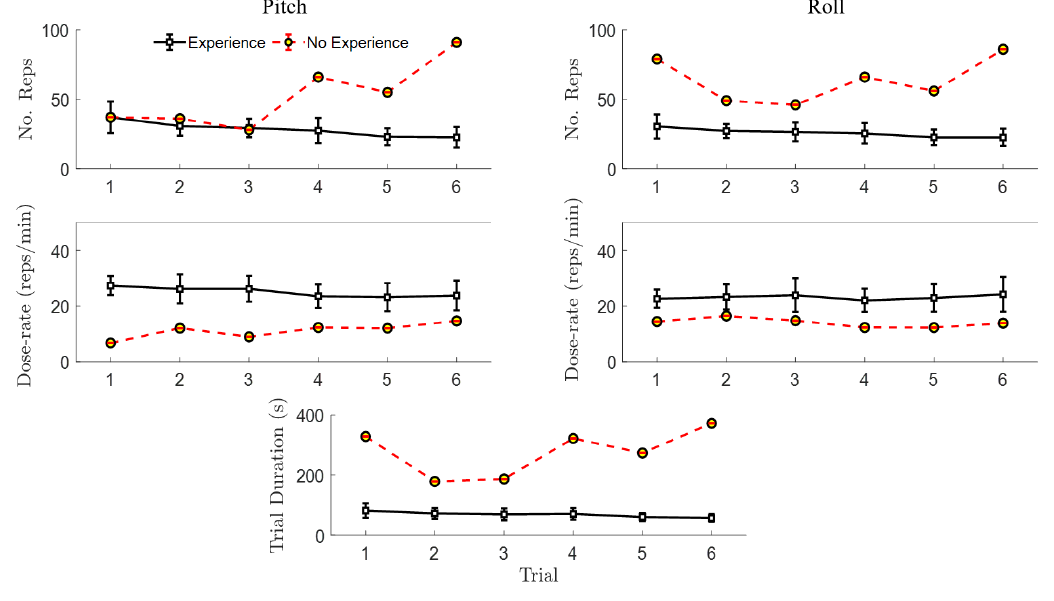
Figure 11. Quantity of movement metrics across six repeated trials for a single participant with no video-game experience compared to the mean ± SD across the participants with video-game